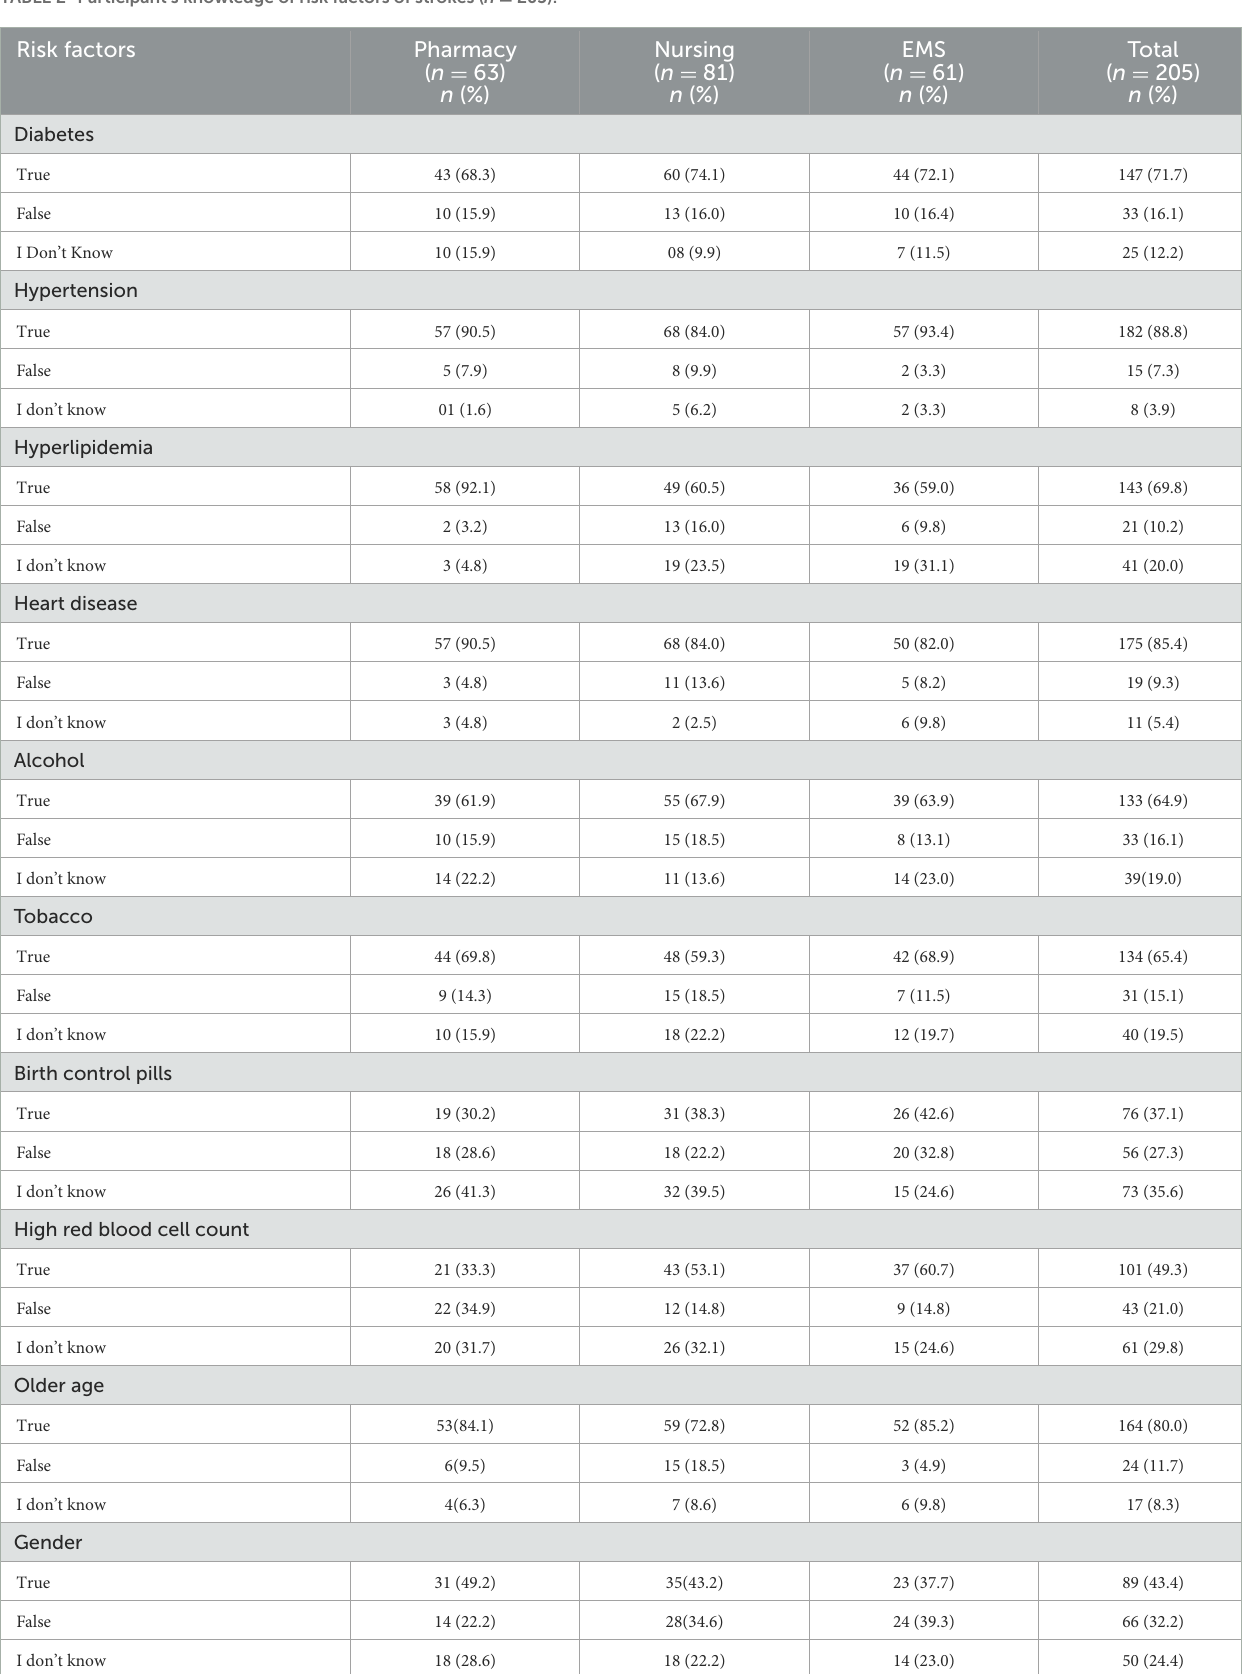
TABLE 2 Participant’s knowledge of risk factors of strokes ( n =